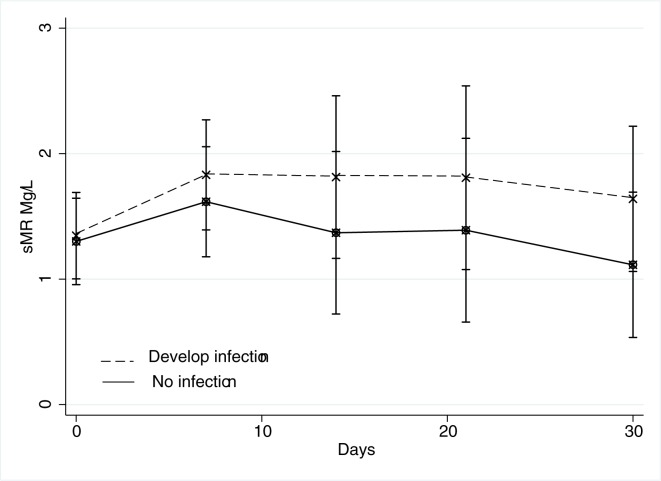
sMR in AH patients by infection.sMR levels in Alcoholic hepatitis patients during the 30-day follow-up allocated by patients who later developed infection n = 8 and patients who did not n = 42. (p = 0.07, repeated measures ANOVA).